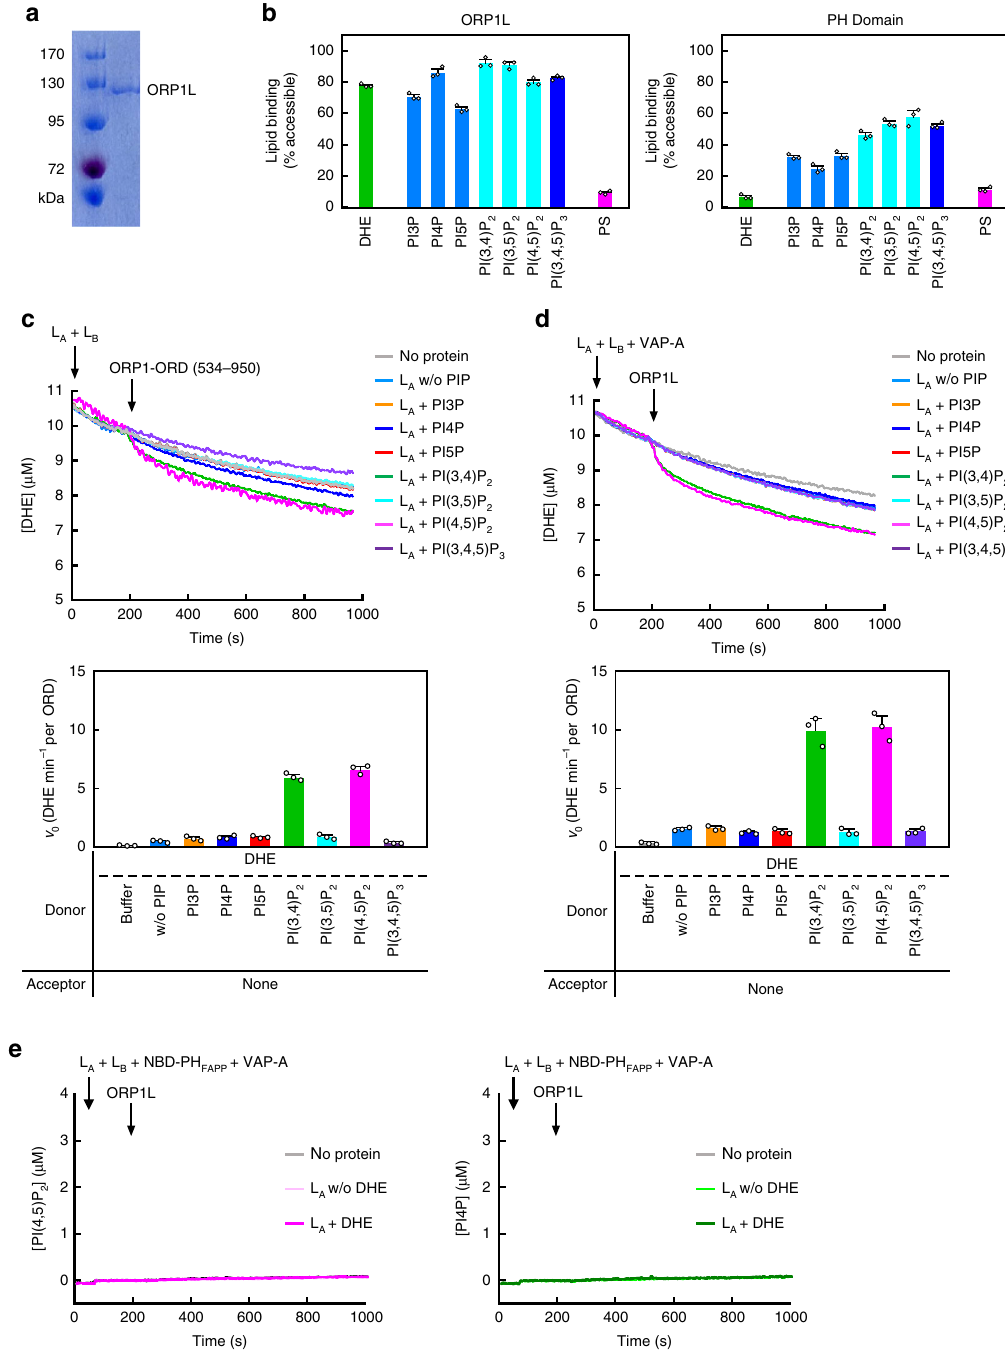
Fig. 3 PI(3,4)P 2 /PI(4,5)P 2 stimulates cholesterol transport by ORP1L in vitro. a SDS-PAGE of full-length ORP1L. b Lipid-binding analyses for ORP1L and its PH Domain. c , d DHE transport assays for ORP1-ORD ( c ) and ORP1L ( d ) with PIP embedded in the donor liposomes. Shown at the bottom are the initial velocities. e PI(4,5)P 2 (left) and PI4P (right) transport assays for ORP1L. (For all bar graphs, data are shown as mean ± s.e.m. (error bar), n = 3) (3,4)P 2 , which led to a delay of cholesterol ef fl ux from LELs in the U18666A-based cholesterol ef fl ux assay as in ORP1L de fi cient cells (Fig. 2i and Supplementary Fig. 4g, h). Consistent with the microscopy results, ACAT activity was moderately but signi fi - a key enzyme in the synthesis of PI(3,4)P 2 on lysosomes 5 . Since cantly reduced in PI3KC2 β knockdown cells (Fig. 2j, k). our data in vitro demonstrated that PI(3,4)P 2 can regulate Interestingly, there was no further reduction of cholesterol cholesterol transport through ORP1, we examined the role of this esteri fi cation in ORP1L de fi cient cells upon PI3KC2 β knock- enzyme in endosomal cholesterol traf fi cking. Knocking down down. These results suggest that PI3KC2 β and ORP1L may PI3KC2 β from HeLa cells dramatically decreased the level of PI function in the same pathway in regulating endosomal cholesterol NATURE COMMUNICATIONS| (2019) 10:829